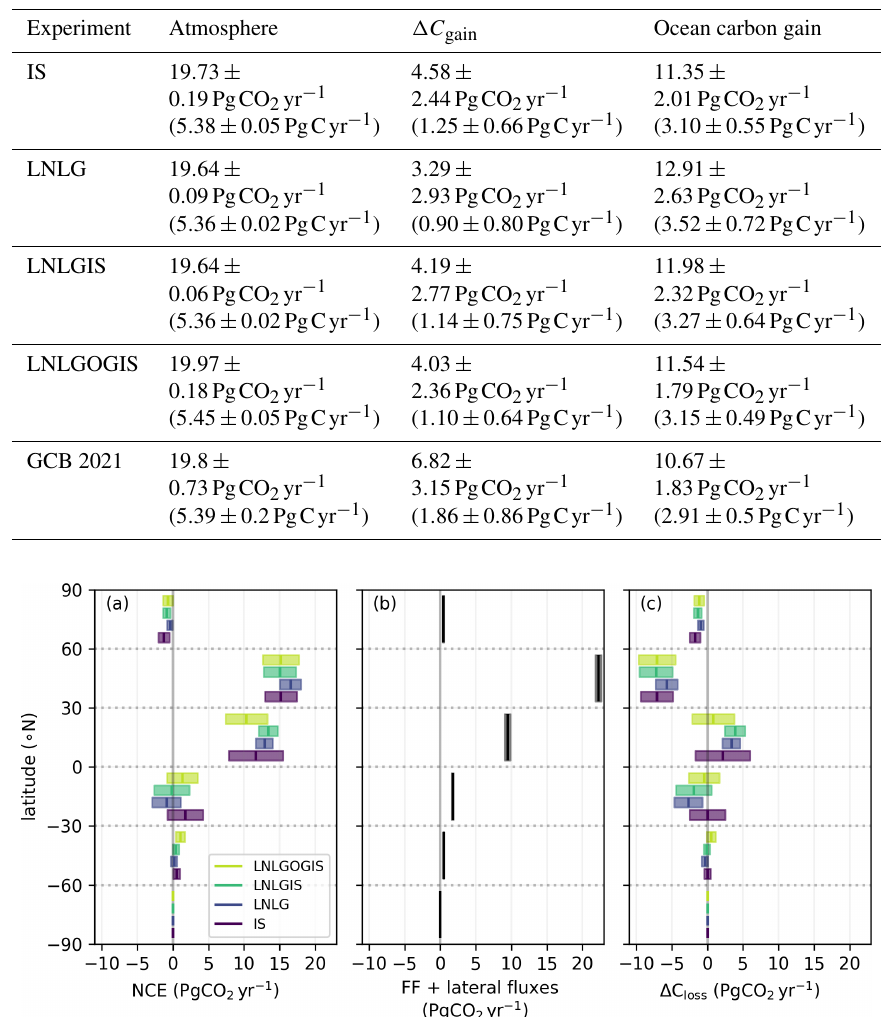
Table 4. 2015–2020 global mean atmospheric increase, terrestrial carbon gain ( (cid:49)C gain ) and ocean carbon gain from the IS, LNLG, LNLGIS and LNLGOGIS experiments (mean/median ± 1 standard deviation). Positive values of (cid:49)C gain and ocean carbon gain indicate increases in carbon stocks. GCB 2021 were obtained from the Global Carbon Budget 2021 (Friedlingstein et al., 2022) with (cid:49)C gain calculated as the difference between the land sink and land-use change emissions with errors propagated in quadrature.